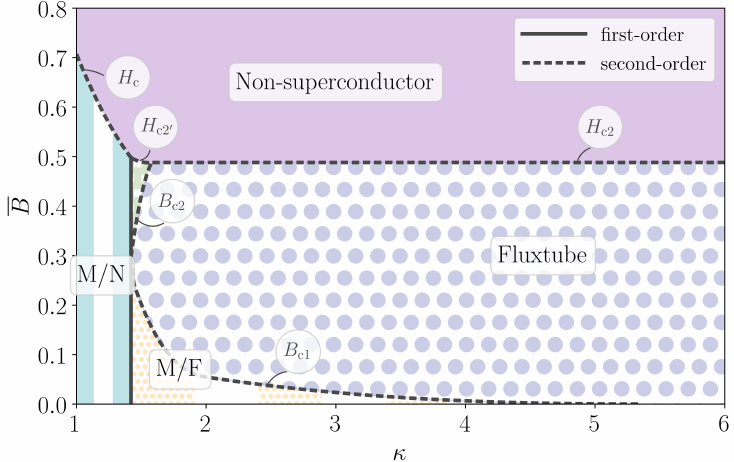
Figure 5. Phase diagrams for the two-component Ginzburg–Landau superconductor, for different values of the Ginzburg–Landau parameter, κ , and other parameters fixed to the same values as in Figure 2. Both figures are plotted in the same style as Figure 1. Shading of the respective regions is indicative of the magnetic flux distribution. In addition to the phases observed for the single- component case (we label the intermediate type-I phase as M/N), we also obtain inhomogeneous regimes where Meissner and fluxtube regions (M/F) as well as fluxtube and non-superconducting regions alternate. We refrain from labeling the latter to avoid overcrowding the plot. These are associated with the appearance of the critical fields H c1 and H c2 , (cid:48) (cid:48)